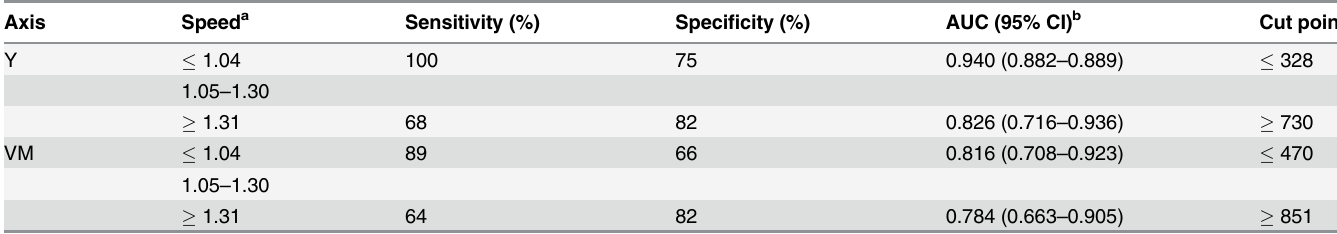
Sensitivity, speci fi city, AUC, and cut points (per 15 s) in the y-axis (vertical) and vector magnitude (VM) for the de fi ned walking speeds. a Walking speed in m/s.